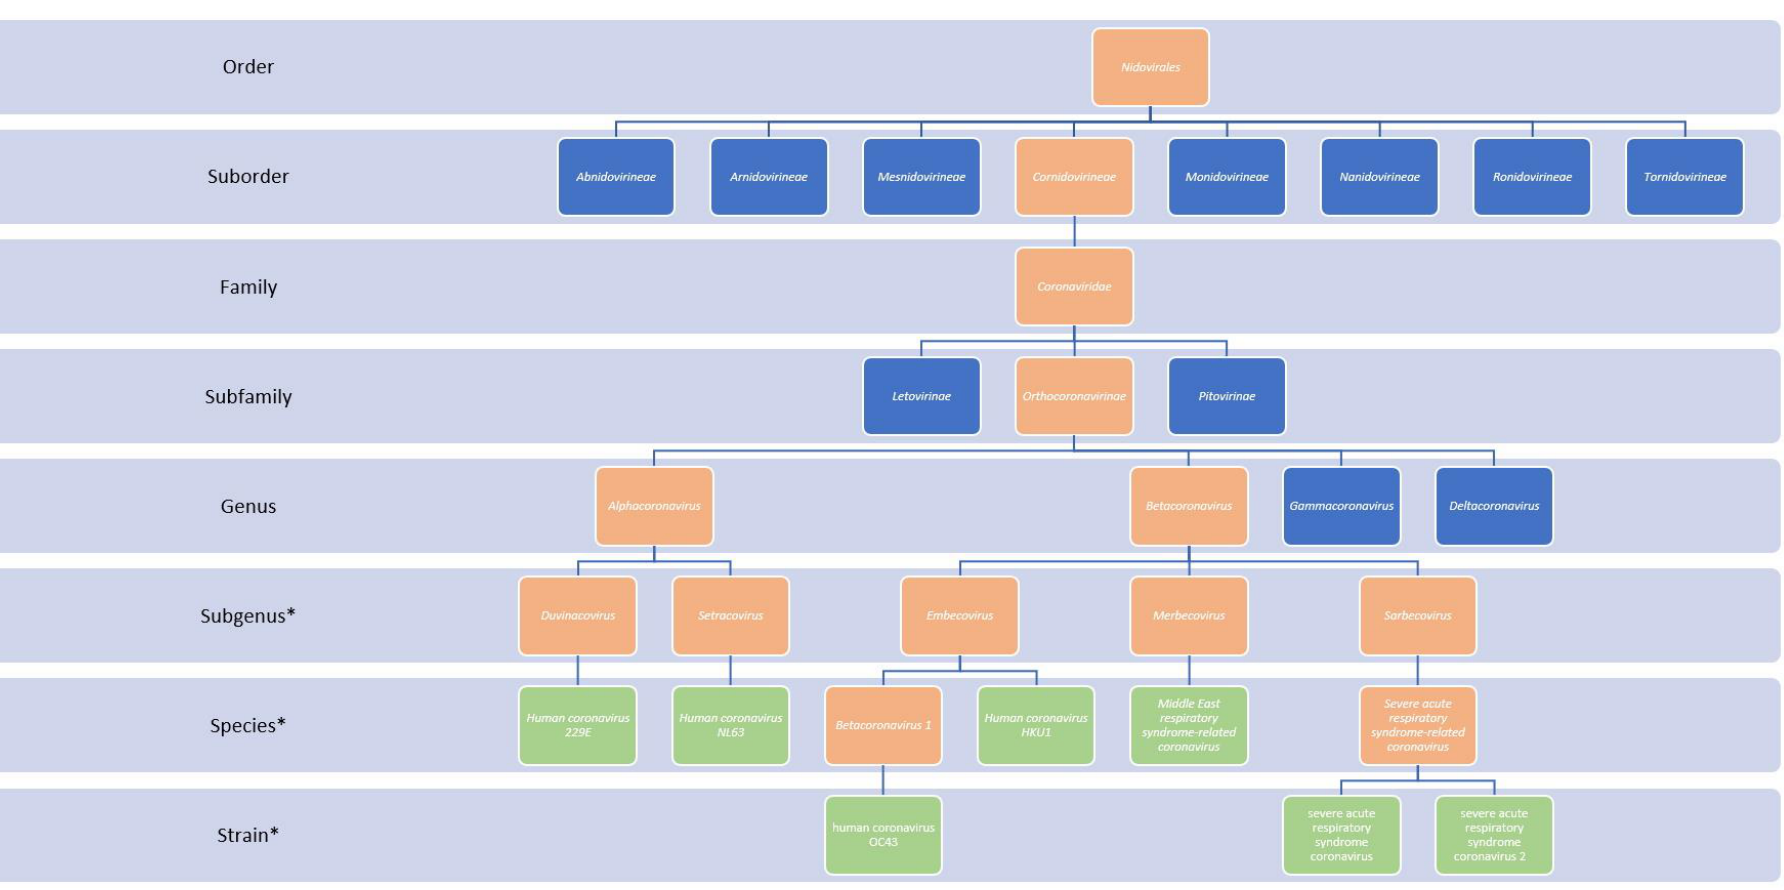
Figure 2. Classification of human coronaviruses. Seven currently recognised human coronavirus species are shown in green, their higher taxonomical categories are shown in orange, and other taxonomical categories are shown in blue. *: not all members of the particular taxonomical category are depicted. Data are based on the International Committee on Taxonomy of Viruses: Current Taxonomy Release 2021 and Master Species List 2021 v3 [32,109].